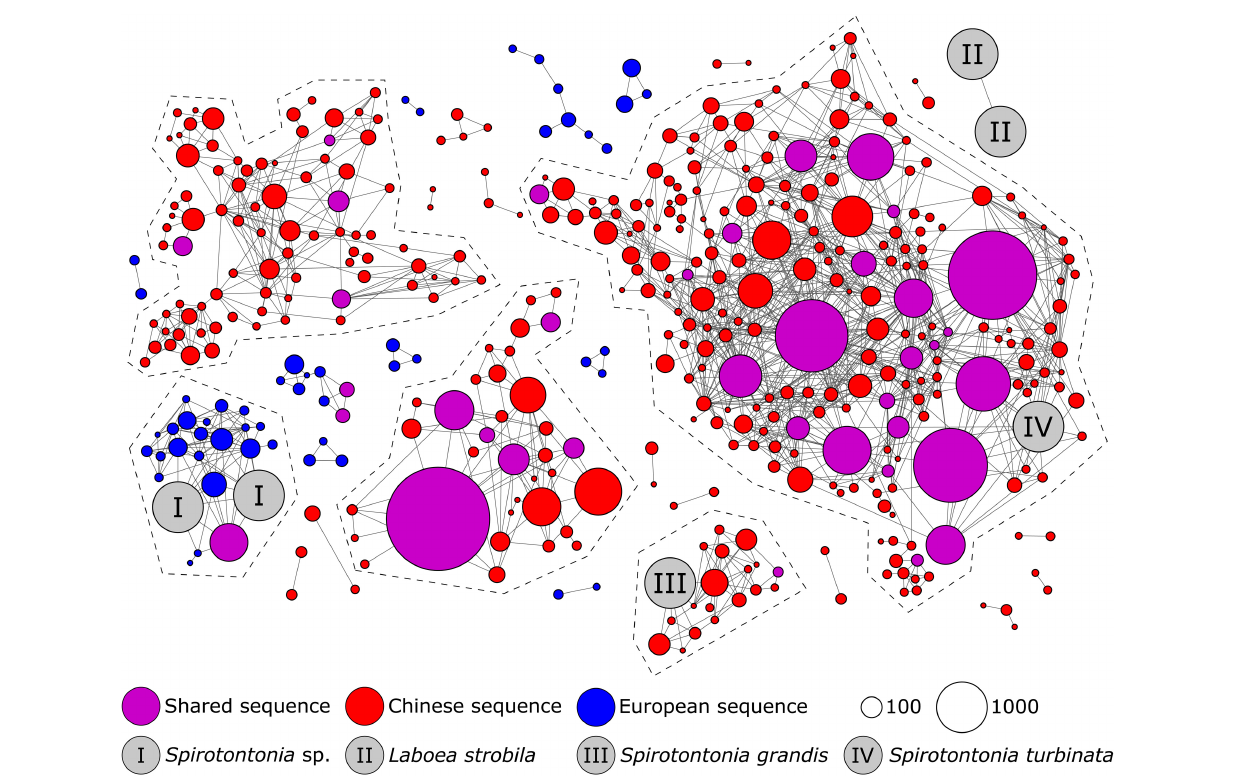
FIGURE 5 | Second-level clustering of the representative amplicons of Swarm OTUs detected in the present study and reference sequences from the PR 2 database assigned to Spirotontonia oligotrichids. At a threshold of 98.5%, the OTUs clustered into five network sequence clusters (NSC), two of which did not contain a reference sequence. Laboea strobila , a supposedly secondarily tail-less tontoniid with a somatic ciliary pattern identical to that in Spirotontonia species, remains separate. The circle sizes correspond to the read numbers of the representative amplicon sequences of the Swarm OTUs. NSCs which indicate potential species are framed by a dashed